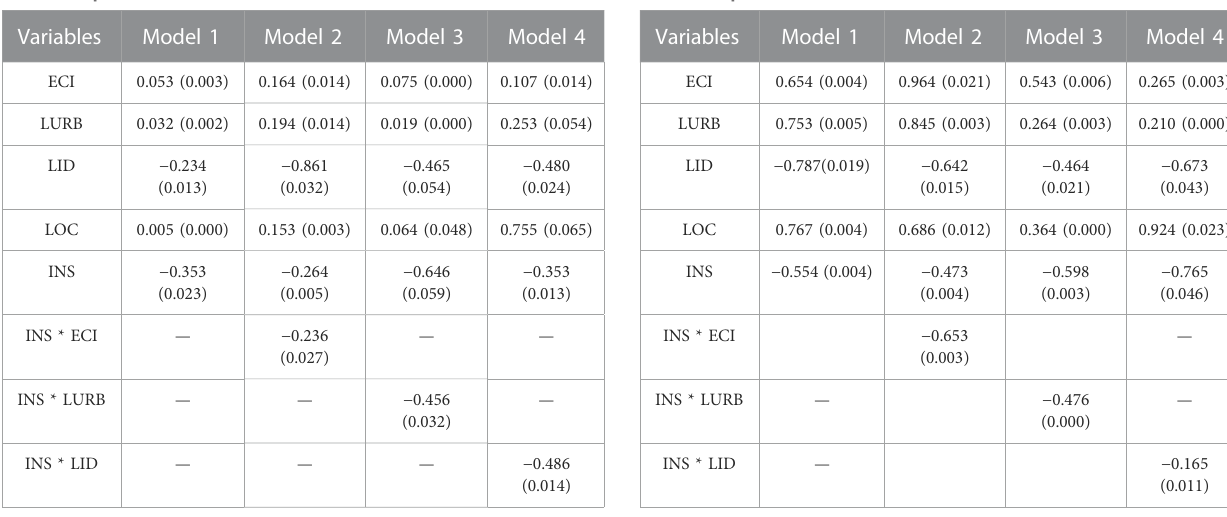
TABLE 8 Cup-BC results. TABLE 7 Cup-FM